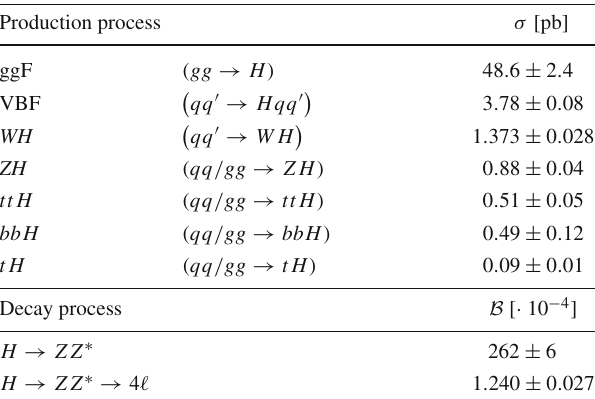
Table 2 The predicted SM Higgs boson production cross-sections ( σ ) for ggF, VBF and five associated production modes in pp collisions for √ m H = 125 GeV at s = 13 TeV [21,24,58–60,66–105]. The quoted uncertaintiescorrespond tothetotaltheoreticalsystematicuncertainties calculated by adding in quadrature the uncertainties due to missing higher-order corrections and PDF + α S . The decay branching ratios ( B